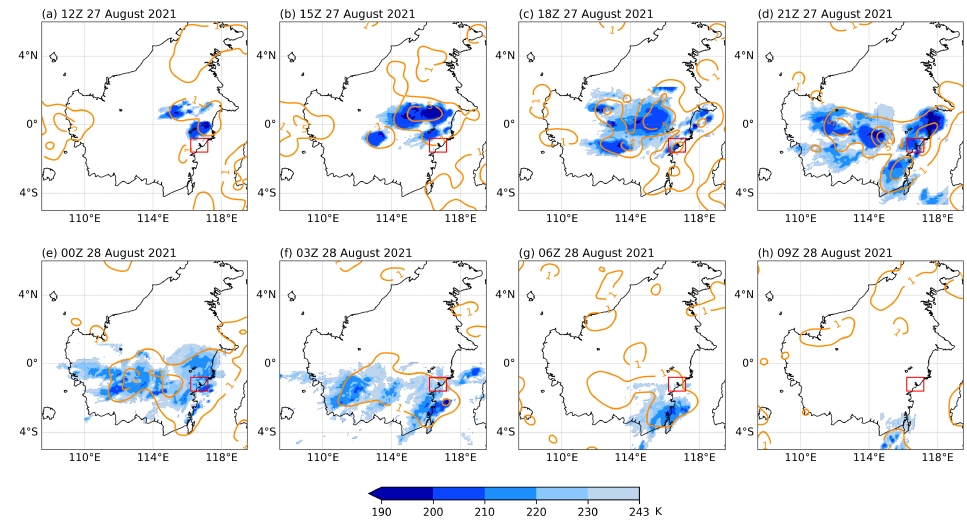
Figure 4. Three-hour evolution of the MCS (K, shaded) from Himawari-8 satellite superimposed with the rainfall rate from GPM IMERG (mm/h, contour) for the period of 27 August at 12Z to 28 August 2021 at 9Z. The location of Nusantara is denoted by a red